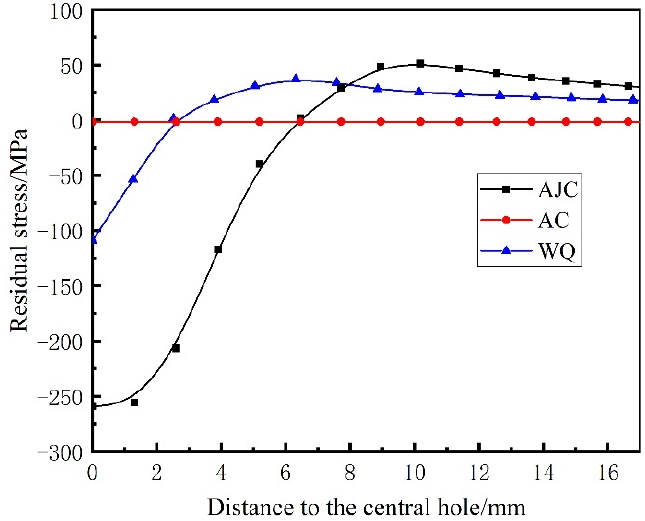
Figure 21. Different residual stress distributions of three cooling methods.